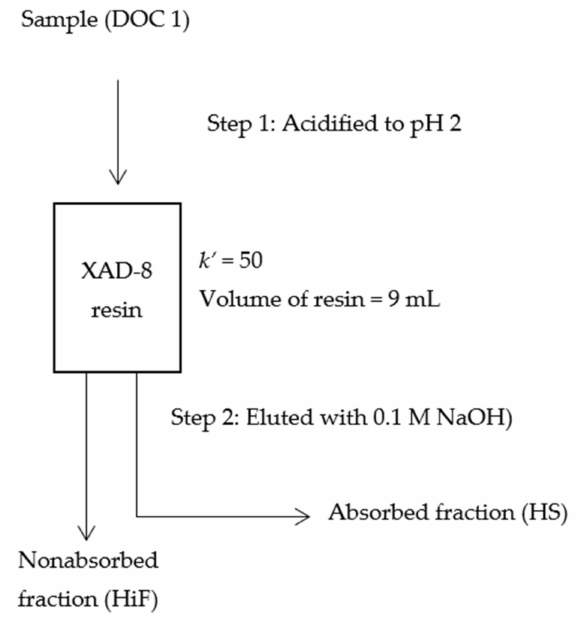
Figure 7. Experimental procedure for separation into absorbed fractions and unabsorbed fractions using soil samples. Details procedures explained and described in Figure 8.